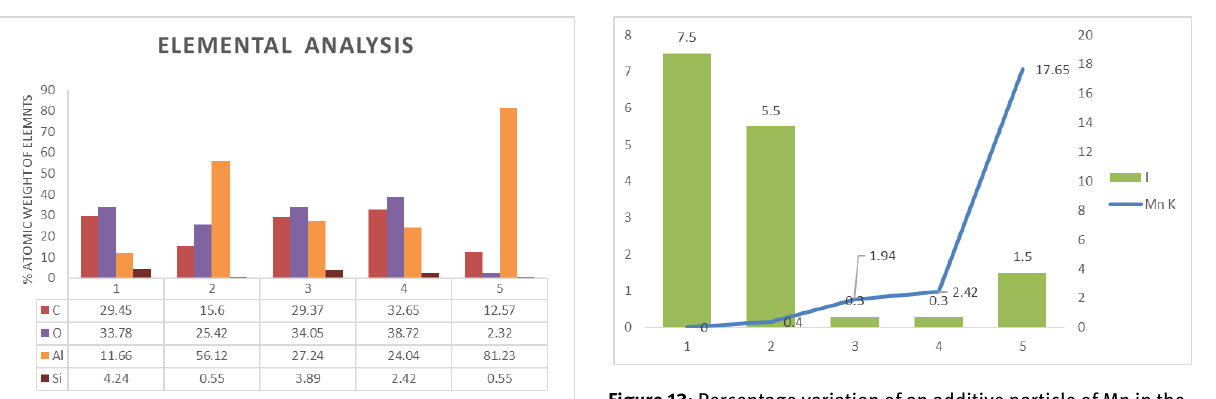
Figure 13: Percentage variation of an additive particle of Mn in the oxide